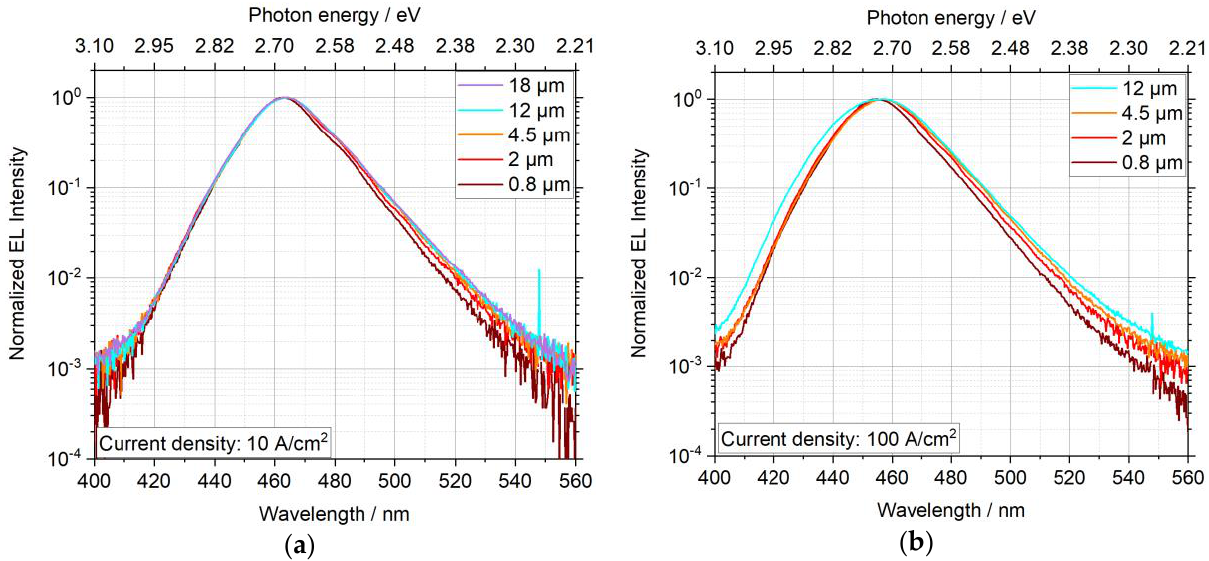
Figure 3. Size-dependent normalized EL spectra at a current density of ( a ) 10 A/cm 2 and ( b ) 100 A/cm 2 for µ LEDs with a diameter between 0.8 and 18 µ m. A semilogarithmic scaling was selected to show the small changes in the curve shape for different sizes. At a current density of 100 A/cm 2 , the emitted light of the µ LED with a diameter of 18 µ m saturated the CCD camera so that the spectrum was omitted.